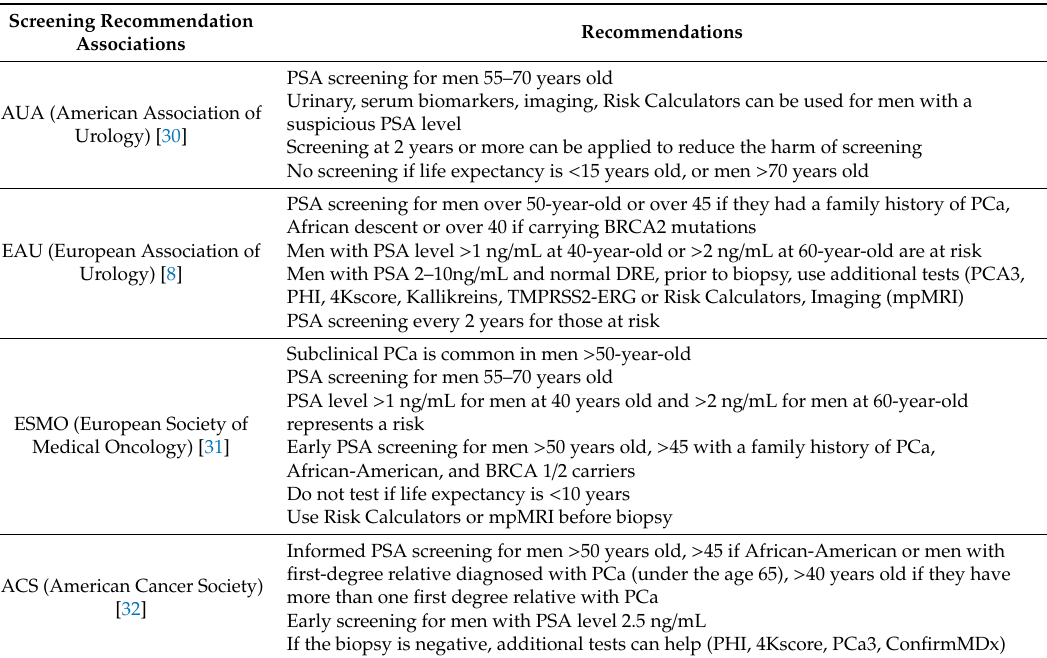
Table 1. Prostate-specific antigen (PSA)-based screening